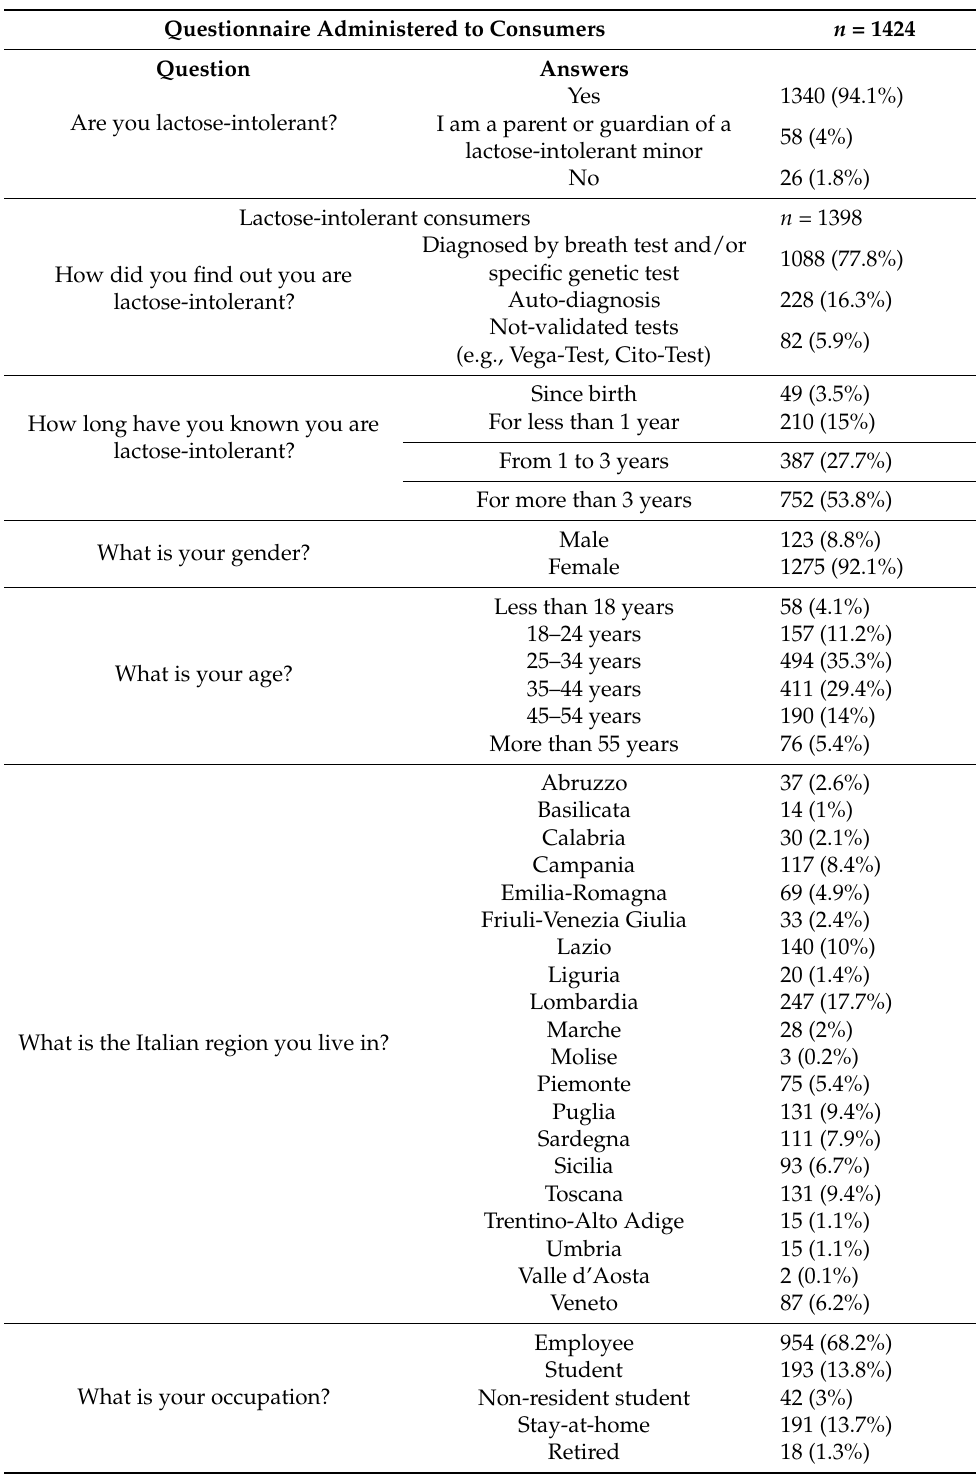
Table 2. Sociodemographic characteristics of lactose-intolerant